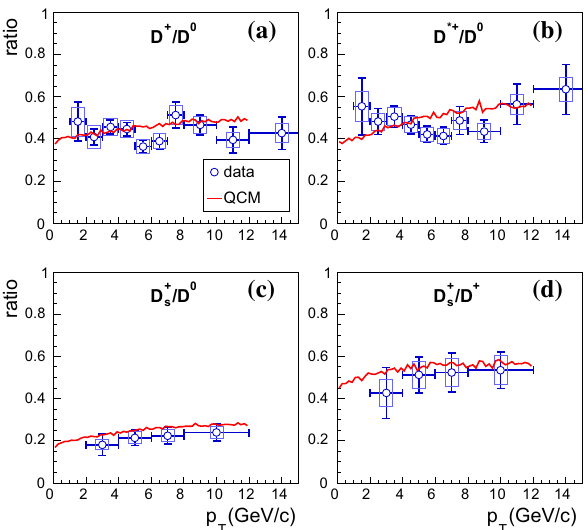
Fig. 3 Ratios of different D mesons as the function of p T in pp colli- √ s = 7 TeV. Symbols are experimental data [40] and lines are sions at results of QCM